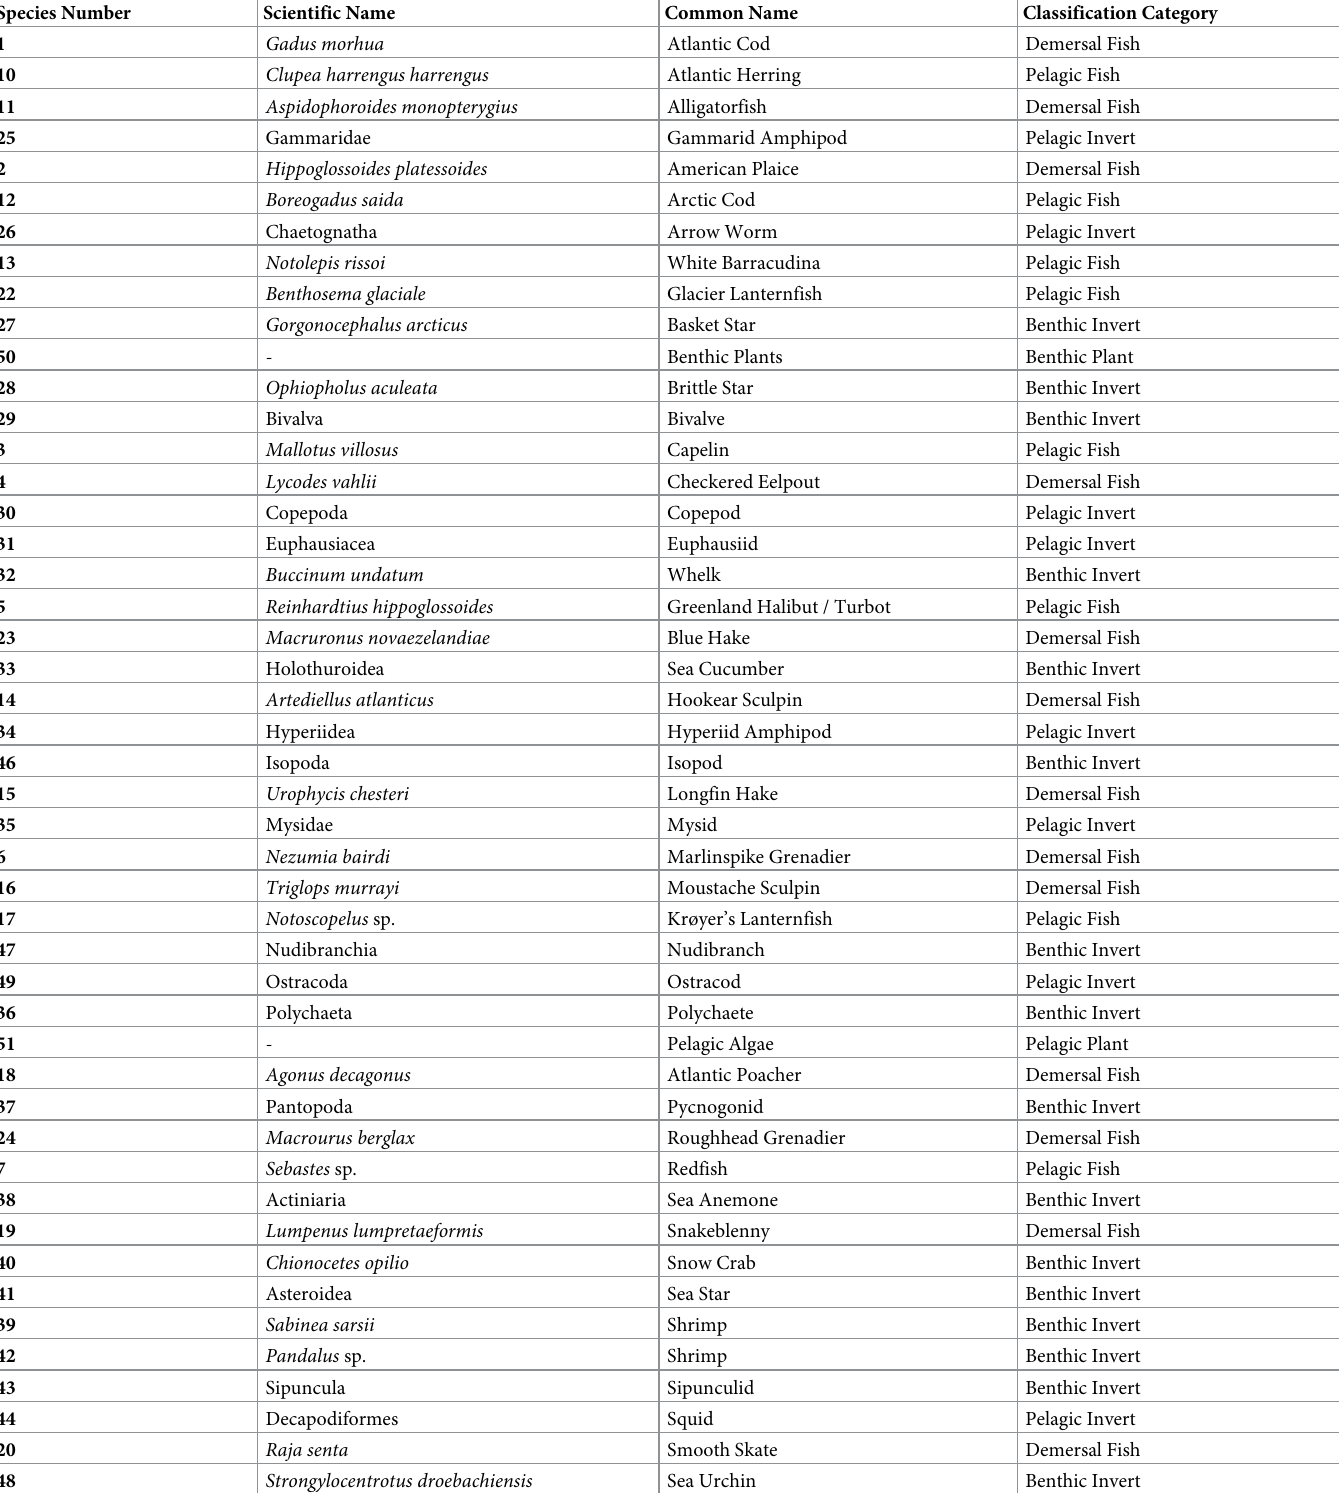
Table 1. Species included in this study, their species abbreviation, and the group category to which they were